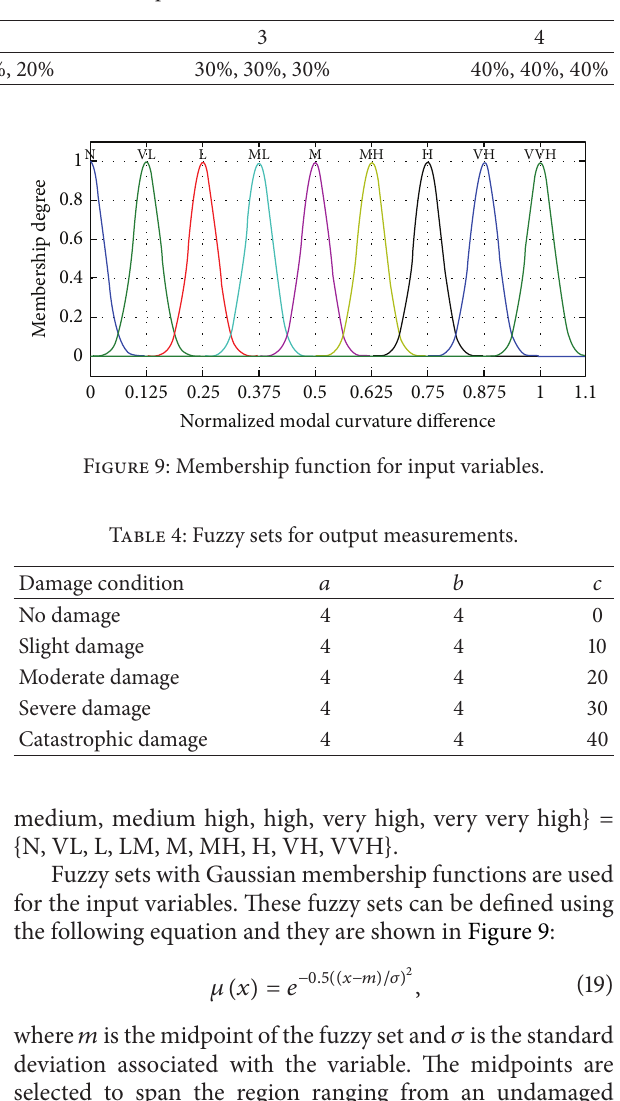
Table 3: Cases for damage localization with multiple locations.